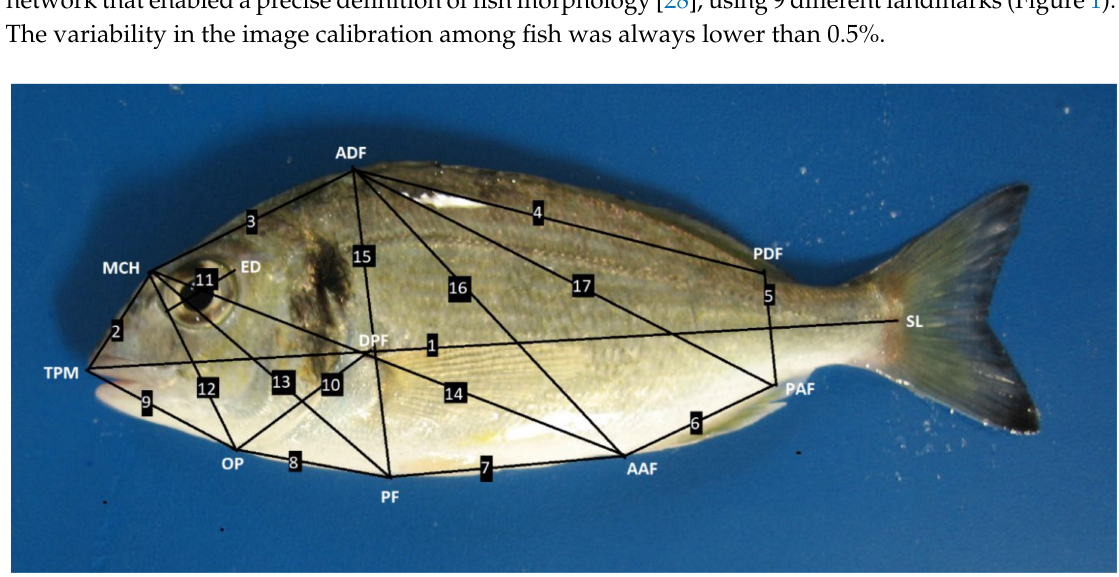
Figure 1. Representation of the seventeen distances measured in fish and used in the morphological analysis described from the subsequent landmarks: the tip of the premaxillar (TPM), the point of the maximum curvature in the head profile curve (MCH), the anterior insertion of the dorsal fin (ADF), the posterior insertion of the dorsal fin (PDF), the anterior insertion of the anal fin (AAF), the posterior insertion of the anal fin (PAF), the anterior insertion of the pelvic fin (PF), the insertion of the operculum in the profile (OP), and the dorsal insertion of the pectoral fin (DPF). The standard length (SL) and the eye diameter (ED) were also included as measure 1 and 11, respectively, in the